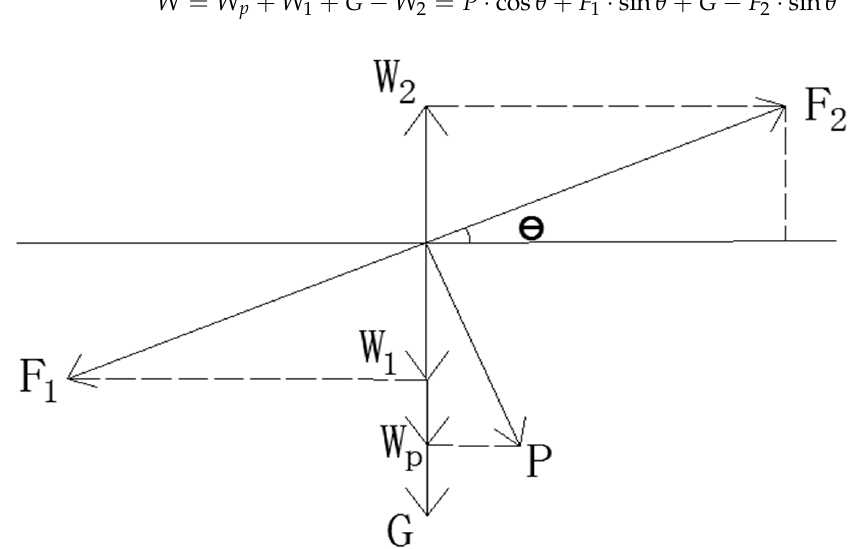
Figure 1. Stress analysis of single a weight on a transport belt.